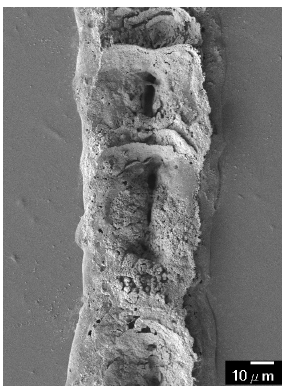
Figure 5. Scanning electron microscope (SEM) image of a silver line fabricated using a 16 mM process solution and 30 laser scans.